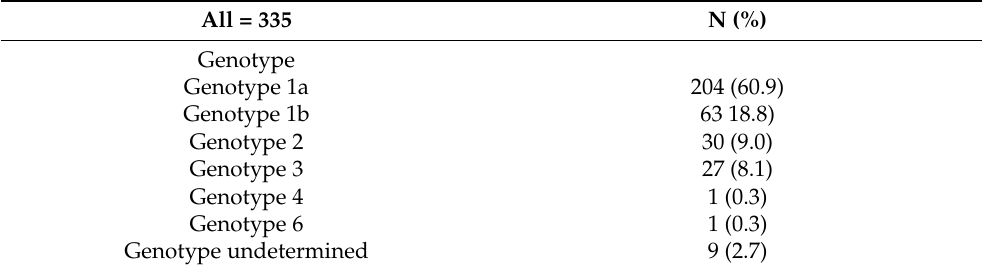
Table 2. Distribution of HCV